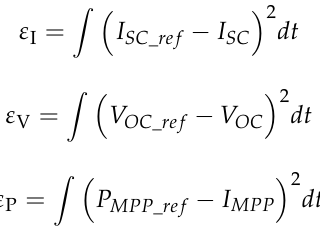
Figure 9. Block diagram depicting the parameter extraction technique used by the proposed Hybrid BESSA BESSA technique.